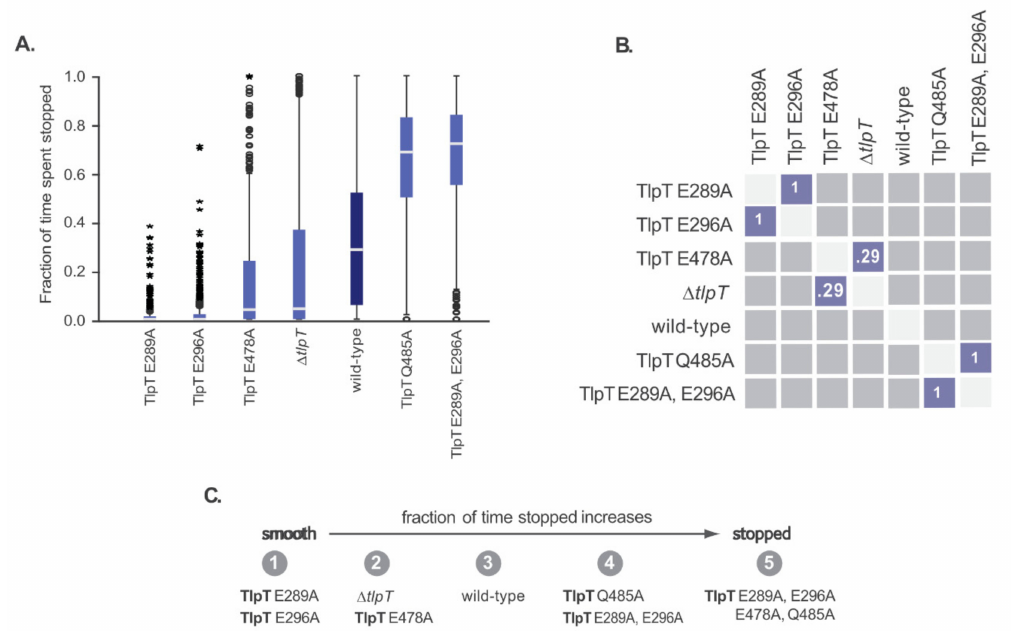
Figure 5. Steady-state swimming phenotypes of TlpT mutants in R. sphaeroides , calculated from tracks collected over 18 min of free swimming video (9 × 2 min), after censoring (see Methods 4.8). Table 3 shows the number of tracks analysed. ( A ) Box plots showing the distribution of fraction of time spent stopped. The box contains the interquartile range (middle 50% of values; IQR), the centre line indicates the median, and the whiskers indicate the minimum and maximum values no smaller / greater than 1.5 × IQR. Circles are outliers 1.5–3.0 × IQR and stars are extreme values more than 3.0 × IQR. ( B ) Post-hoc pairwise comparisons between distributions of fraction of time spent stopped for each mutant (following a Kruskal Wallis test with p < 0.001). Numbers indicate the p -value for that comparison. Comparisons not shown are p < 0.001. Blue squares indicate pairs that are not significantly di ff erent from one another ( p ≥ 0.05). ( C ) Strains grouped based on the proportion of time spent stopped, as judged by pairwise comparisons, from smooth swimming to very